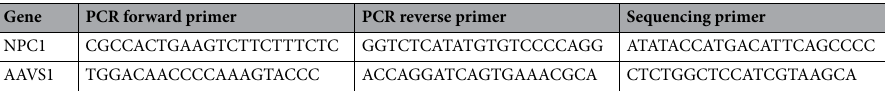
Table 1. Primers for amplification and sequencing of endogenous